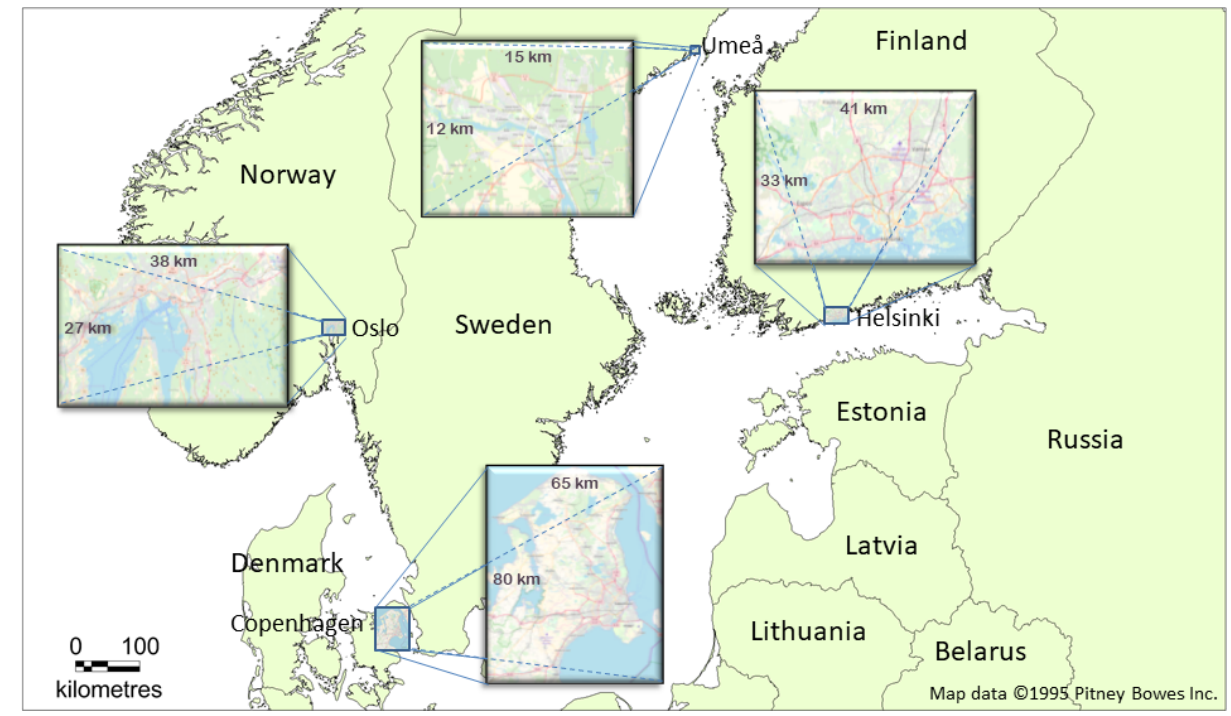
Figure 1. The locations of the selected cities and domains. The physical sizes of the domains have been indicated in the inserted smaller